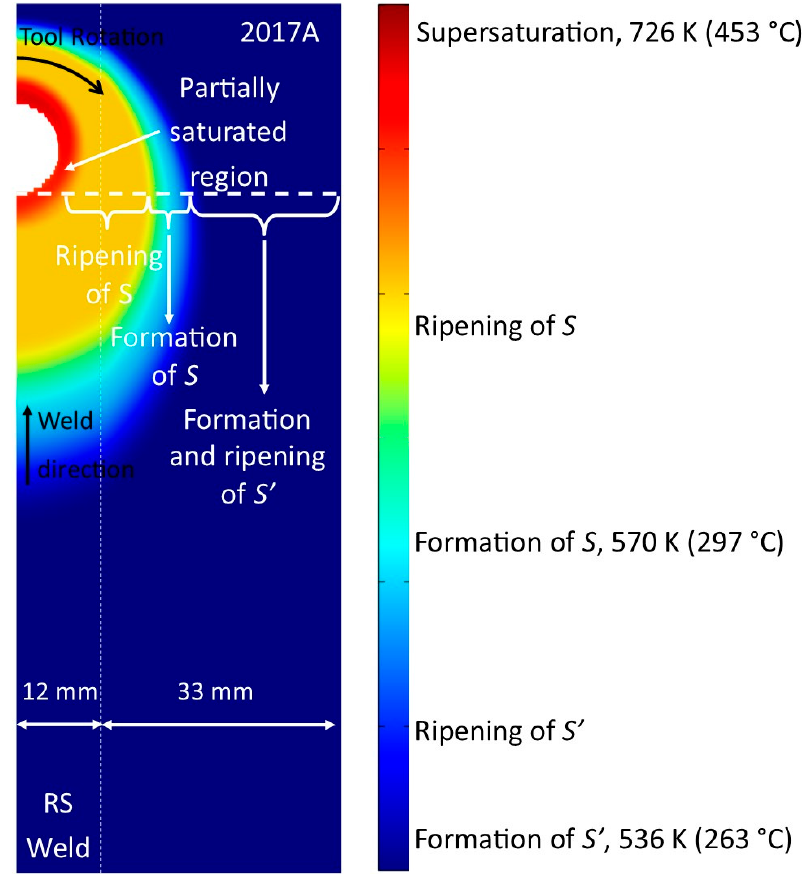
Figure 5. Phase transformation map for 2017A representatively shown on the retreating side. Regions of phase transformations associated with S ’/ S phases are annotated.